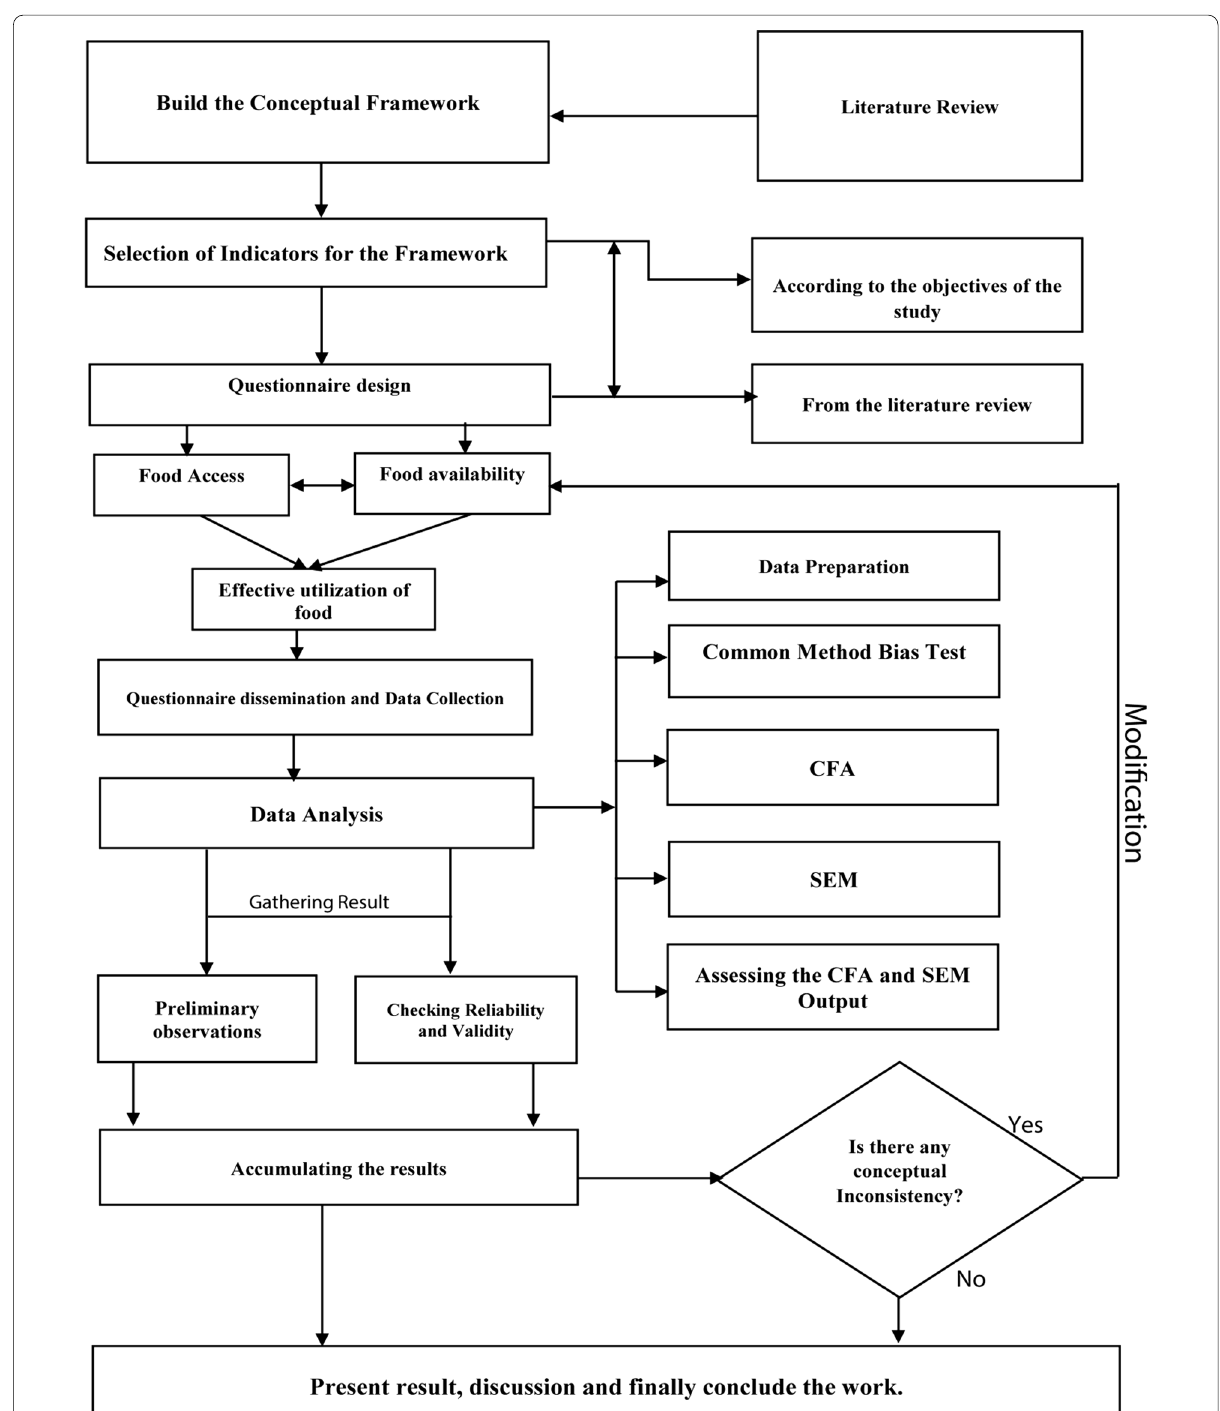
Fig. 1 Steps of the current study. Adapted and modified from Sarkar et al.